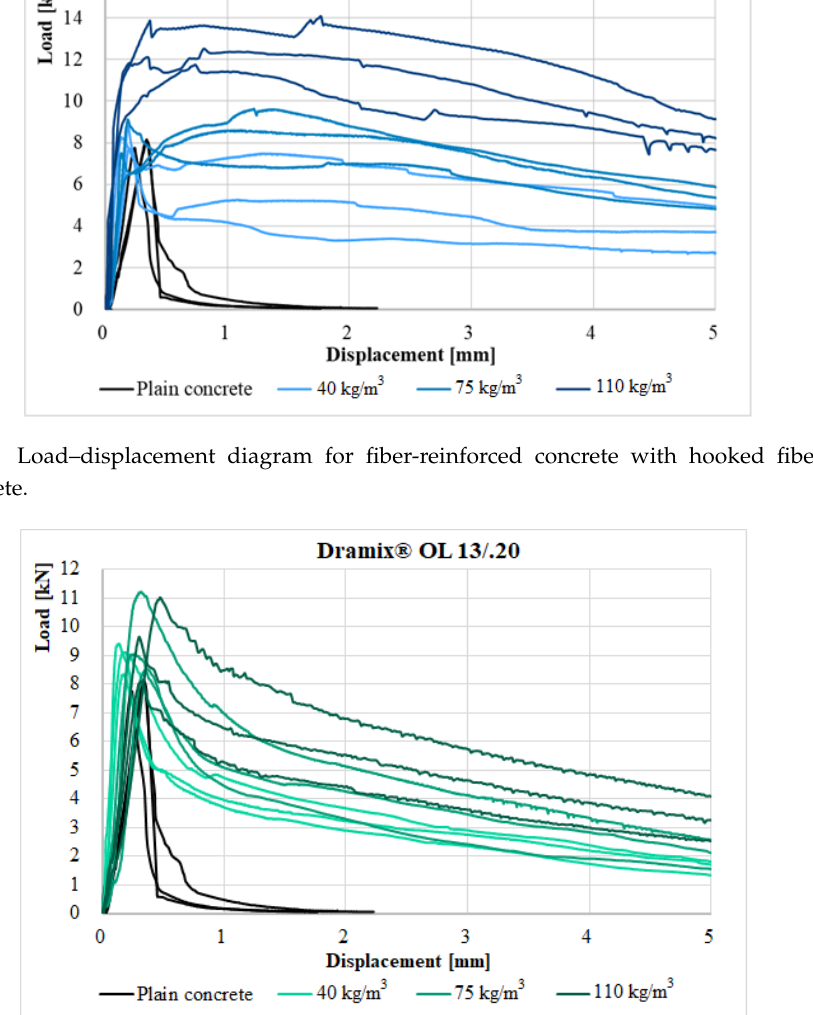
Figure 17. Load–displacement diagram for fiber-reinforced concrete with straight fibers and plain concrete.